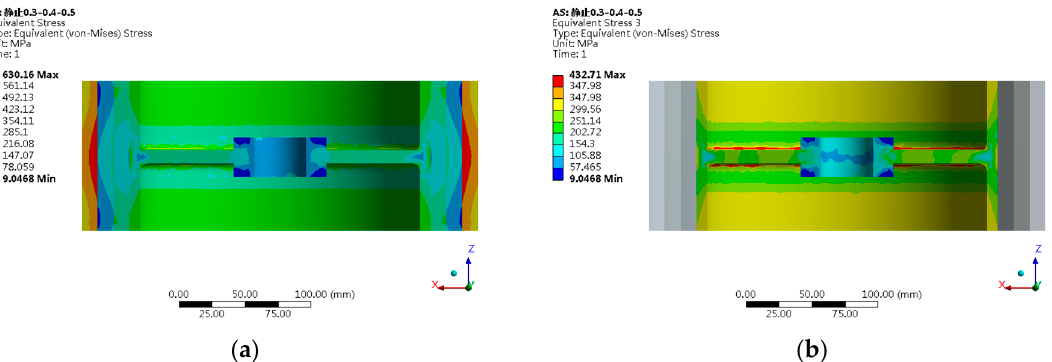
Figure 11. Equivalent stress nephogram of flywheel rotor in a static state. ( a ) Overall equivalent stress cloud diagram of flywheel rotor; ( b ) Equivalent stress cloud map of the wheel hub.